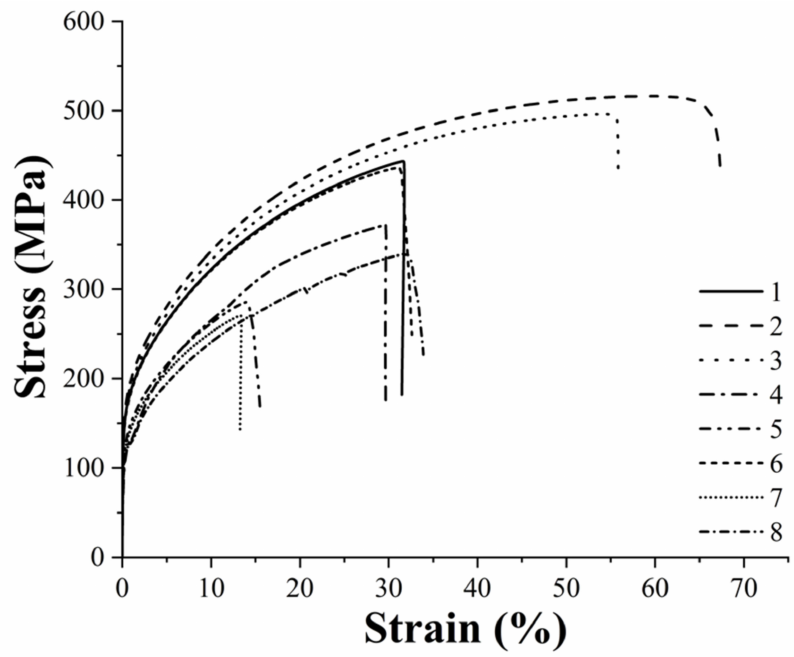
Figure 6. Typical tensile curves of the eight printing configurations under consideration (the numbers in the legend stand for the number of printing profiles investigated, as numbered in Table